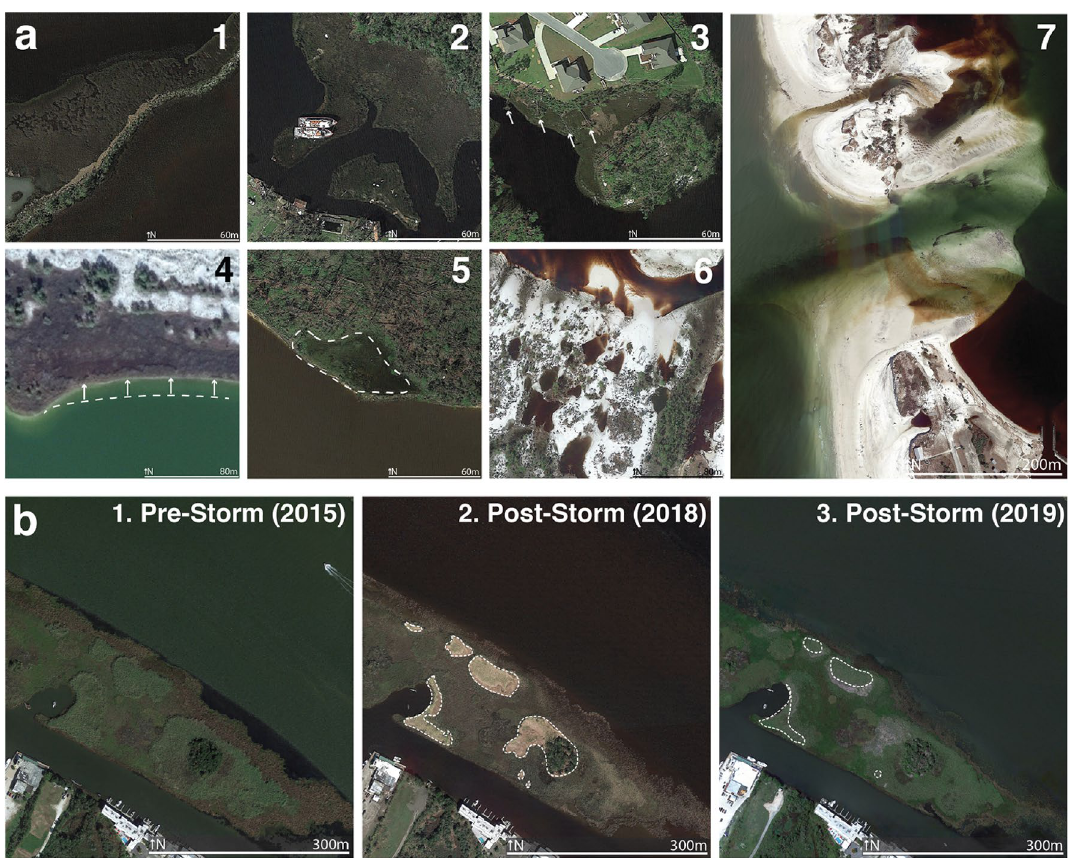
Figure 2. Examples of observed damage and recovery types. (a) Examples of marsh damage from Hurricane Michael include: (1) deposition of vegetation or sediment, (2) man-made debris, (3) fallen trees, (4) lateral erosion, (5) vegetation loss , (6) conversion to open water, and (7) channel cutting/widening. Example locations are indicated in Fig. S1. ( b) Example of (1) pre-storm imagery (16 October 2015); (2) post-storm imagery (12 October 2018) with damaged areas indicated by dashed line; and (3) imagery 6 months after landfall (27 April 2019), with recovered areas indicated by dashed line. Example location indicated in Fig. 5, inset. Aerial imagery from Google Earth Pro